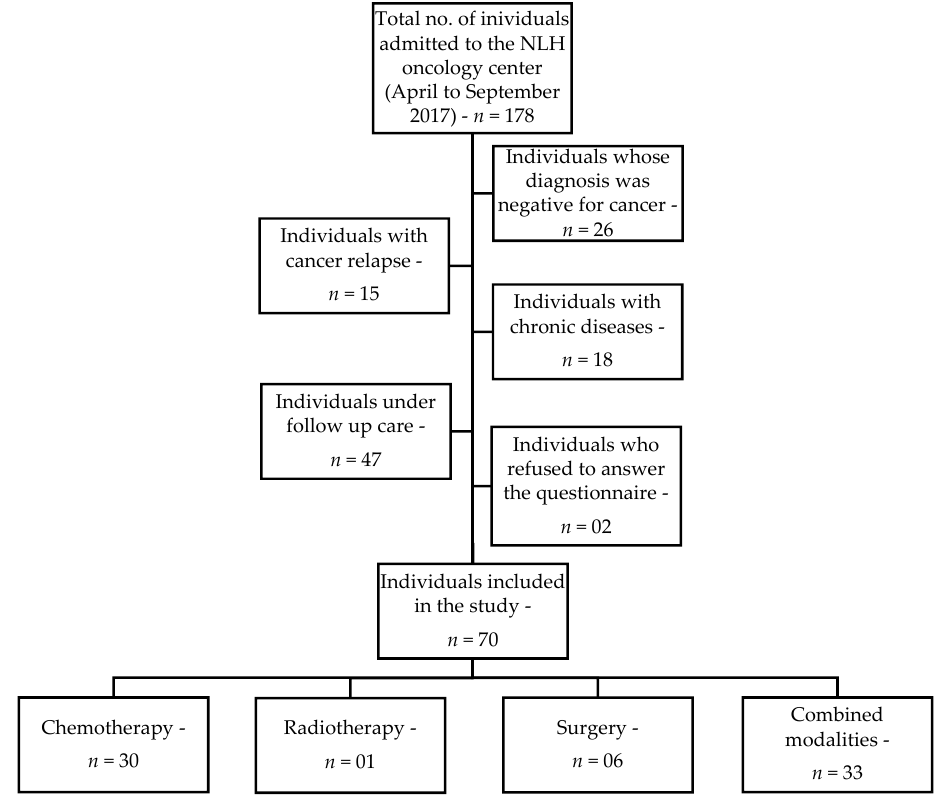
Figure 1. Flowchart of study sample selection.